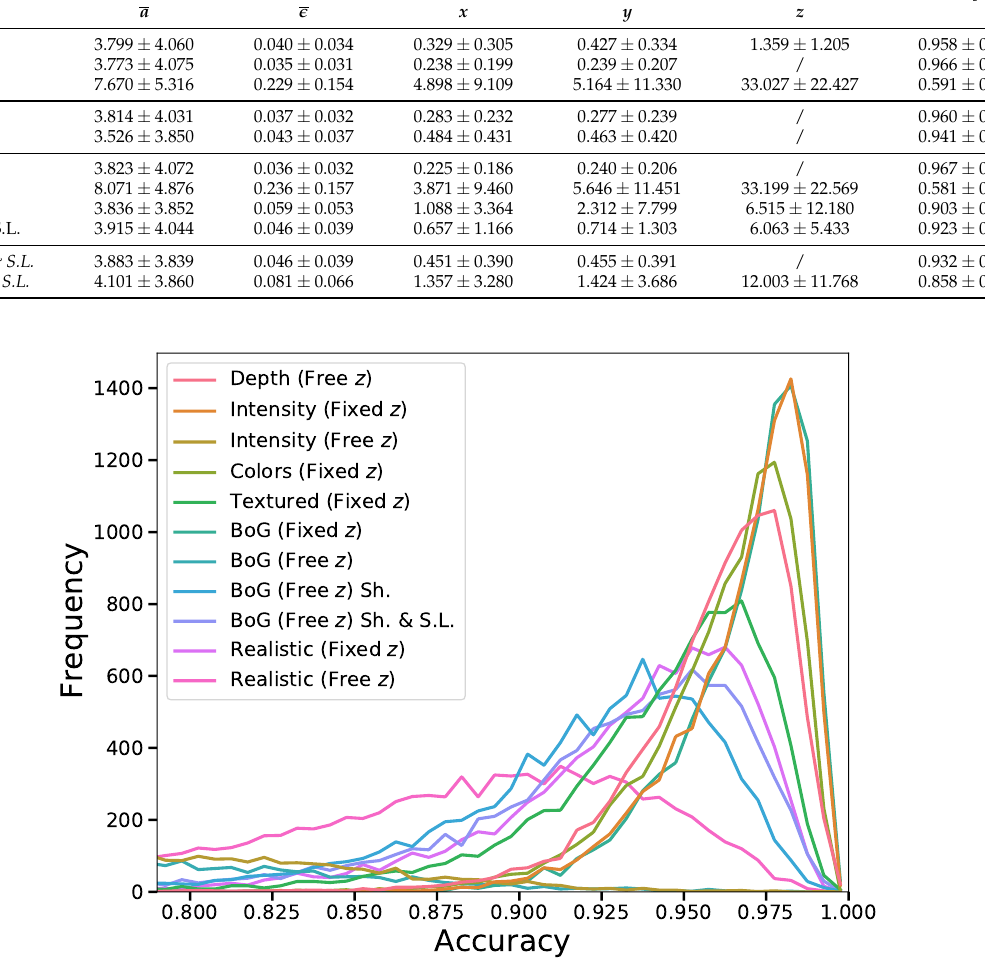
Figure 6. IoU score distributions of CNN predictors trained on different datasets. The distributions are based on predictions of the corresponding test images. Clear performance decay can be observed with increasing complexities of